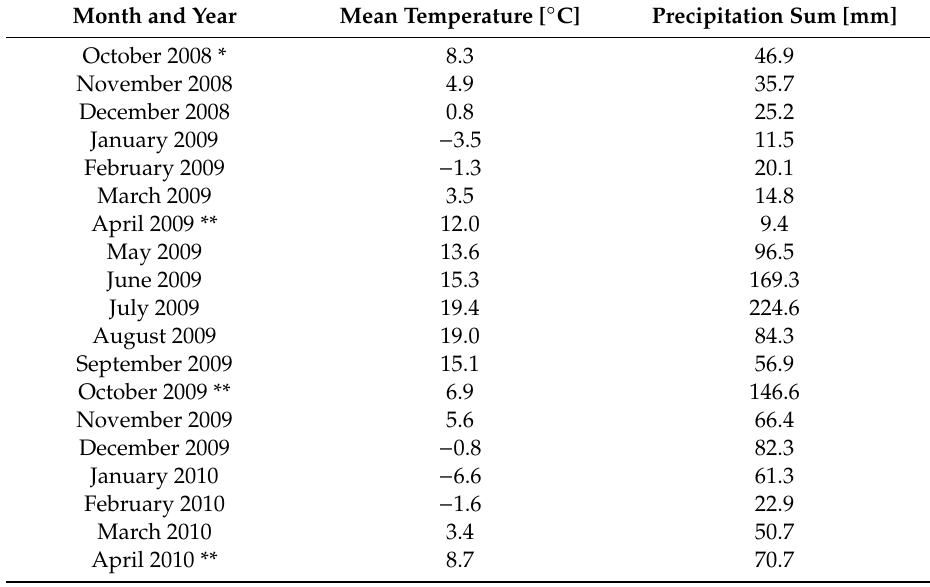
Table A1. Monthly mean temperatures and precipitation sums recorded during the experiment in Biadaszki Forest Experimental Station (ca. 1 km from study site). Setup and collection dates are marked by * and **,